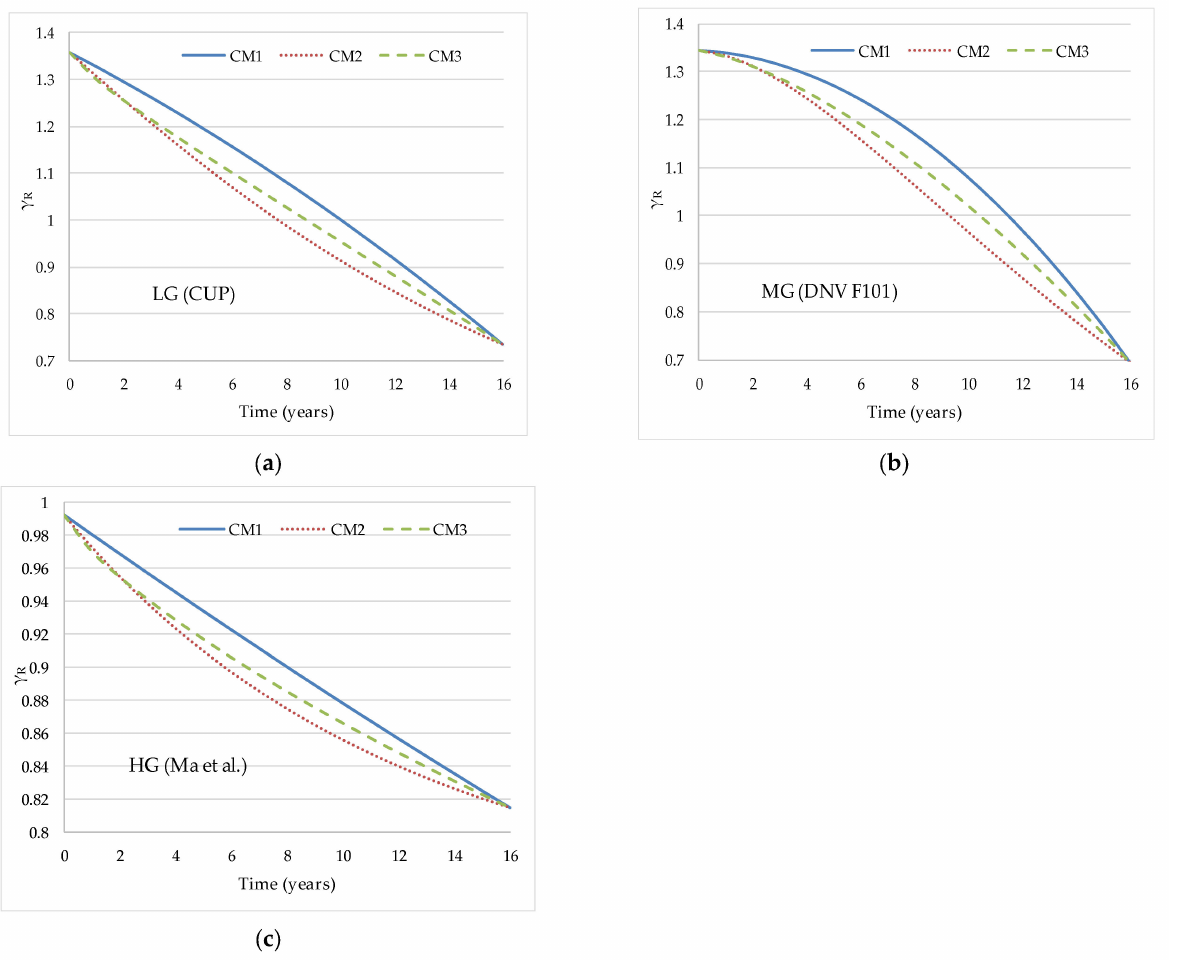
Figure 8. Influence of corrosion growth models on partial safety factors (years) for ( a ) low-grade, ( b ) medium-grade, and ( c ) high-grade steel